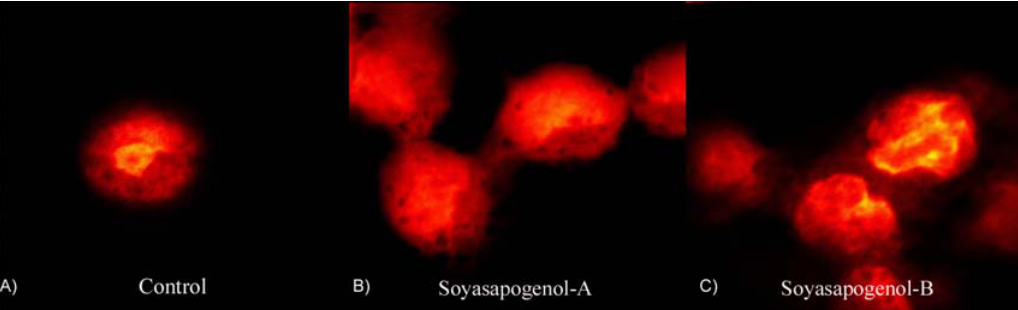
Figure 3. Confocal laser scanning images of propidium iodide stained hepatocarcinoma (Hep-G2).